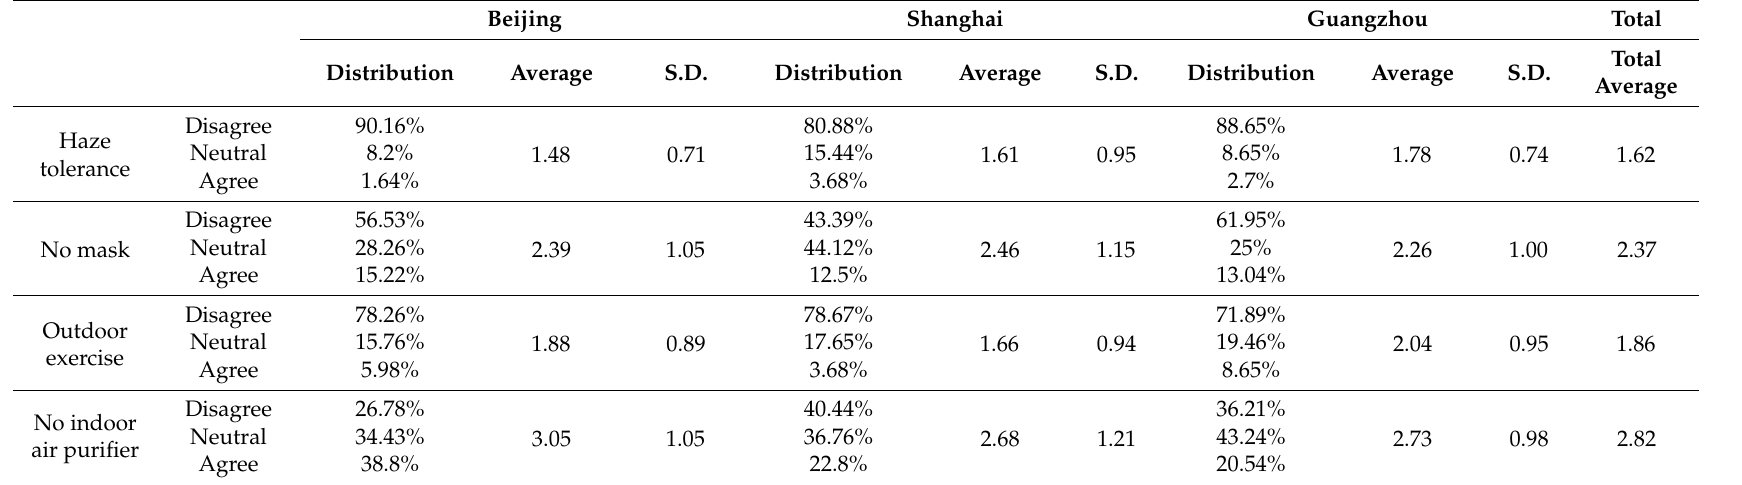
Table 3. Distribution of tolerance degree in Beijing, Shanghai, and Guangzhou.